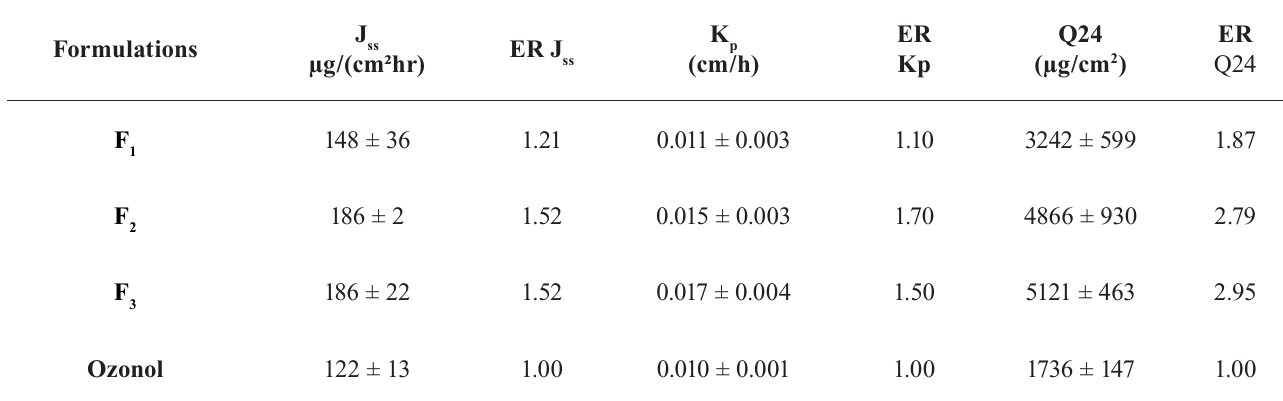
TABLE III - Formulations and respective permeation parameters, according to in vitro permeation studies in epidermis. The J represents the flux at steady-state; K the Permeability coefficient; Q24 the Cumulative amount of IBU permeated after 24h. p Data are expressed as mean ± SEM (n=6)